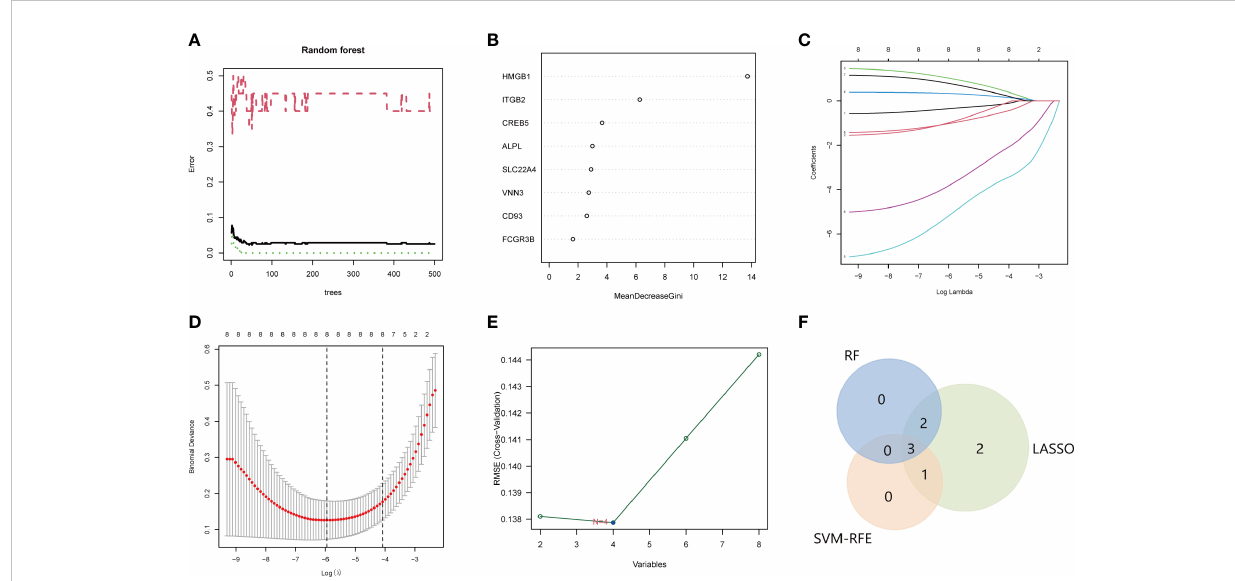
FIGURE 5 Identi fi cation of the hub genes for SLE. A-B. RF to screen candidate hub genes. (A) The in fl uence of the number of decision trees on the error rate. The x-axis is the number of decision trees and the y-axis is the error rate. Green represents the SLE samples, red represents the non-SLE samples, and black represents the overall samples. (B) Gini importance measure. The horizontal axis represents the mean decrease Gini, and the vertical axis represents characteristic NRGs. C-D. LASSO logistic regression to screen candidate hub genes. (C) LASSO coef fi cient spectrum of eight genes enrolled and generate a coef fi cient distribution map for a logarithmic sequence. (D) The 10-fold cross-validation process was repeated 10 times to select the optimal penalization coef fi cient lambda. The value of lambda yielded the minimum average binomial deviance that was used to select features. (E) The RMSE of candidate hub genes combination of the SVM algorithm. The minimum classi fi cation error (minimal RMSE = 0.1377) in the condition of four candidate genes. (F) The Venn diagram shows the overlap of candidate genes among the above three algorithms. SLE, systemic lupus erythematosus; RF, random forest; NRGs, NETs-related genes; LASSO, least absolute shrinkage, and selection operator; RMSE, root-mean- square error; SVM, support vector